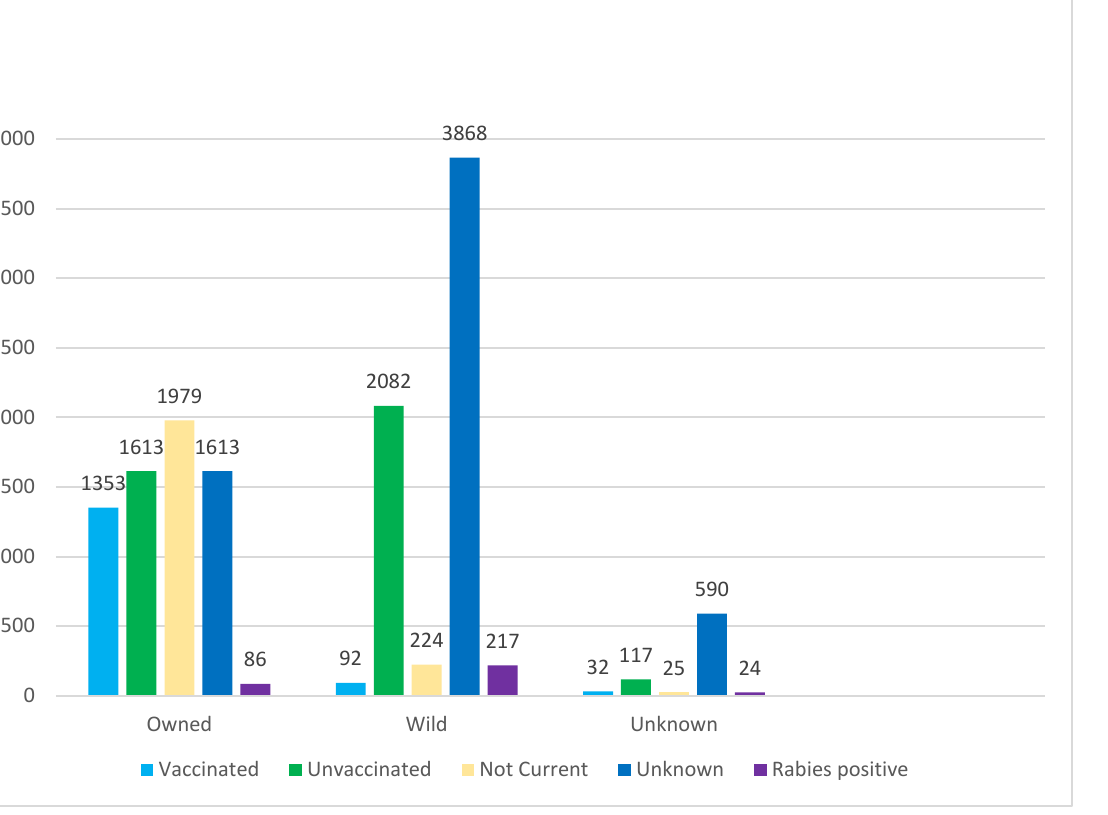
Figure 1. Ownership and vaccination status of cats submitted to the New York State Department of Health (NYSDOH) Rabies